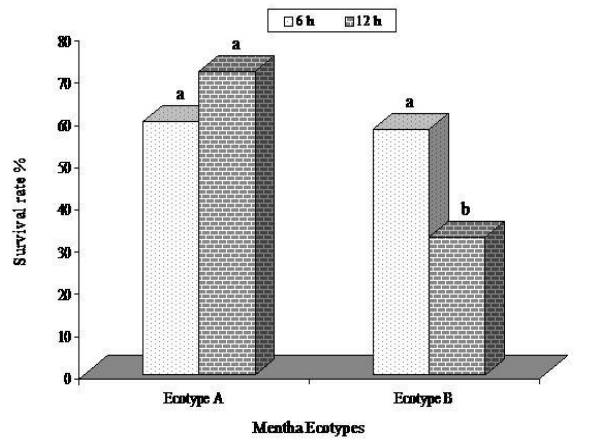
Fig. 1. The effect of different colchicine concentrations on survival rate